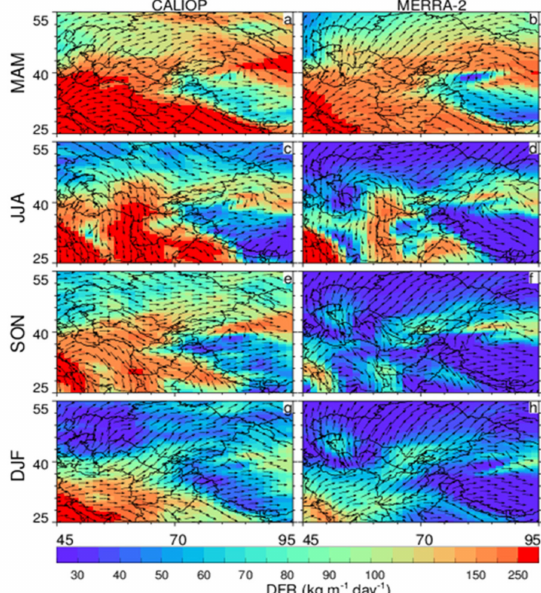
Figure 3. A composite of column–integrated zonal and meridional DFRs (kg m − 1 day − 1 ) derived from CALIOP ( left ) and MERRA–2 ( right ) in ( a , b ) spring (MAM: March–April–May), ( c , d ) summer (JJA: June–July–August), ( e , f ) autumn (SON: September–October–November), and ( g , h ) winter (DJF: December–January–February), showing the magnitude (color scale) and direction (arrow of vector) of dust transport in the atmosphere and its seasonal